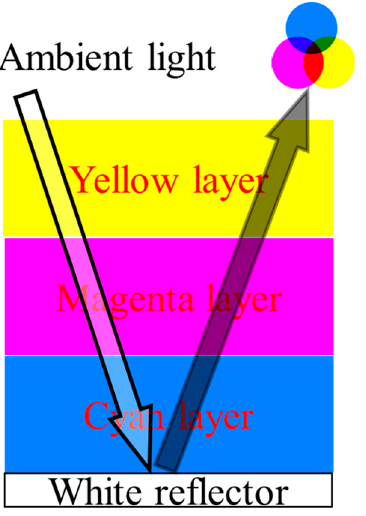
Figure 1. The cross-sectional structure of 3-layer subtractive color EWD.